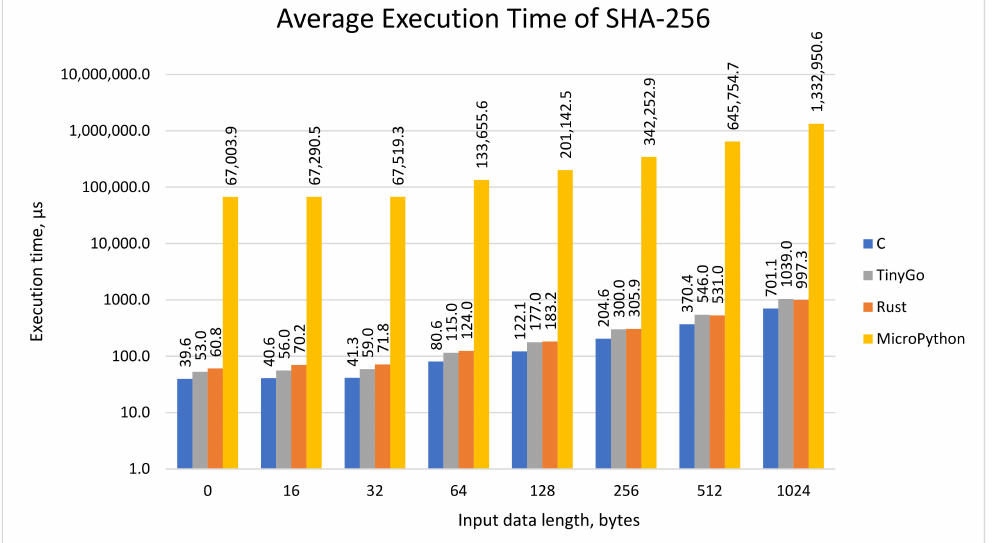
Figure 6. Average execution times of the SHA-256 algorithm (please note the logarithmic time scale).